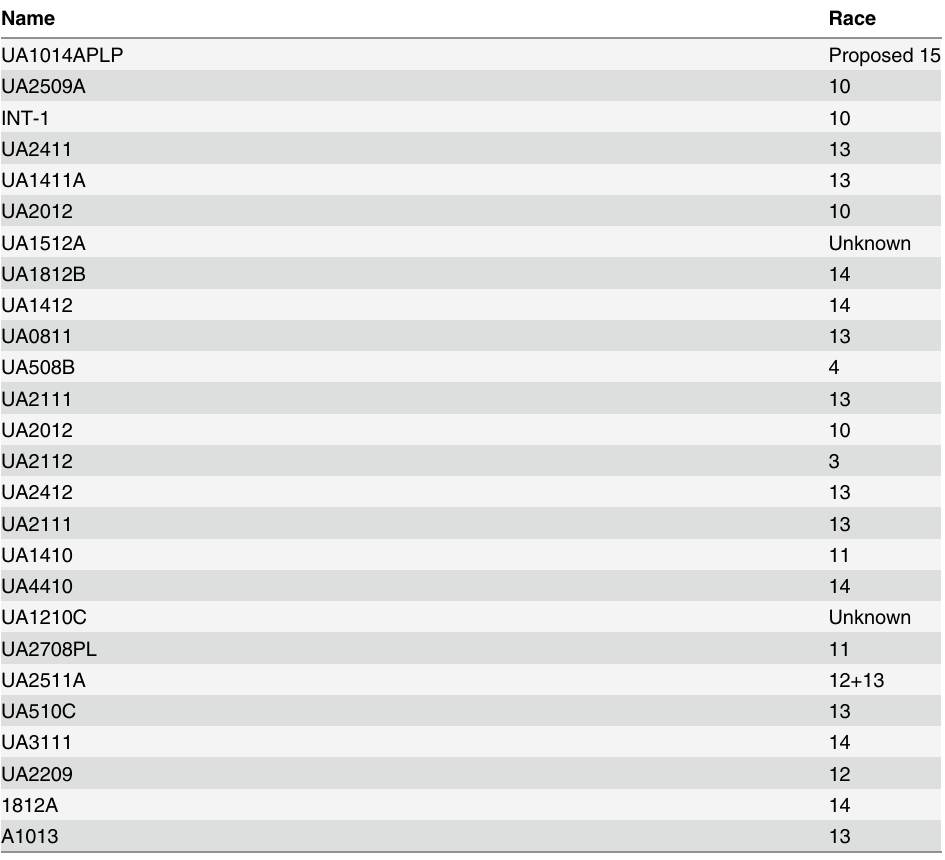
Table 1. Historical panel of isolates and race types (if known or newly